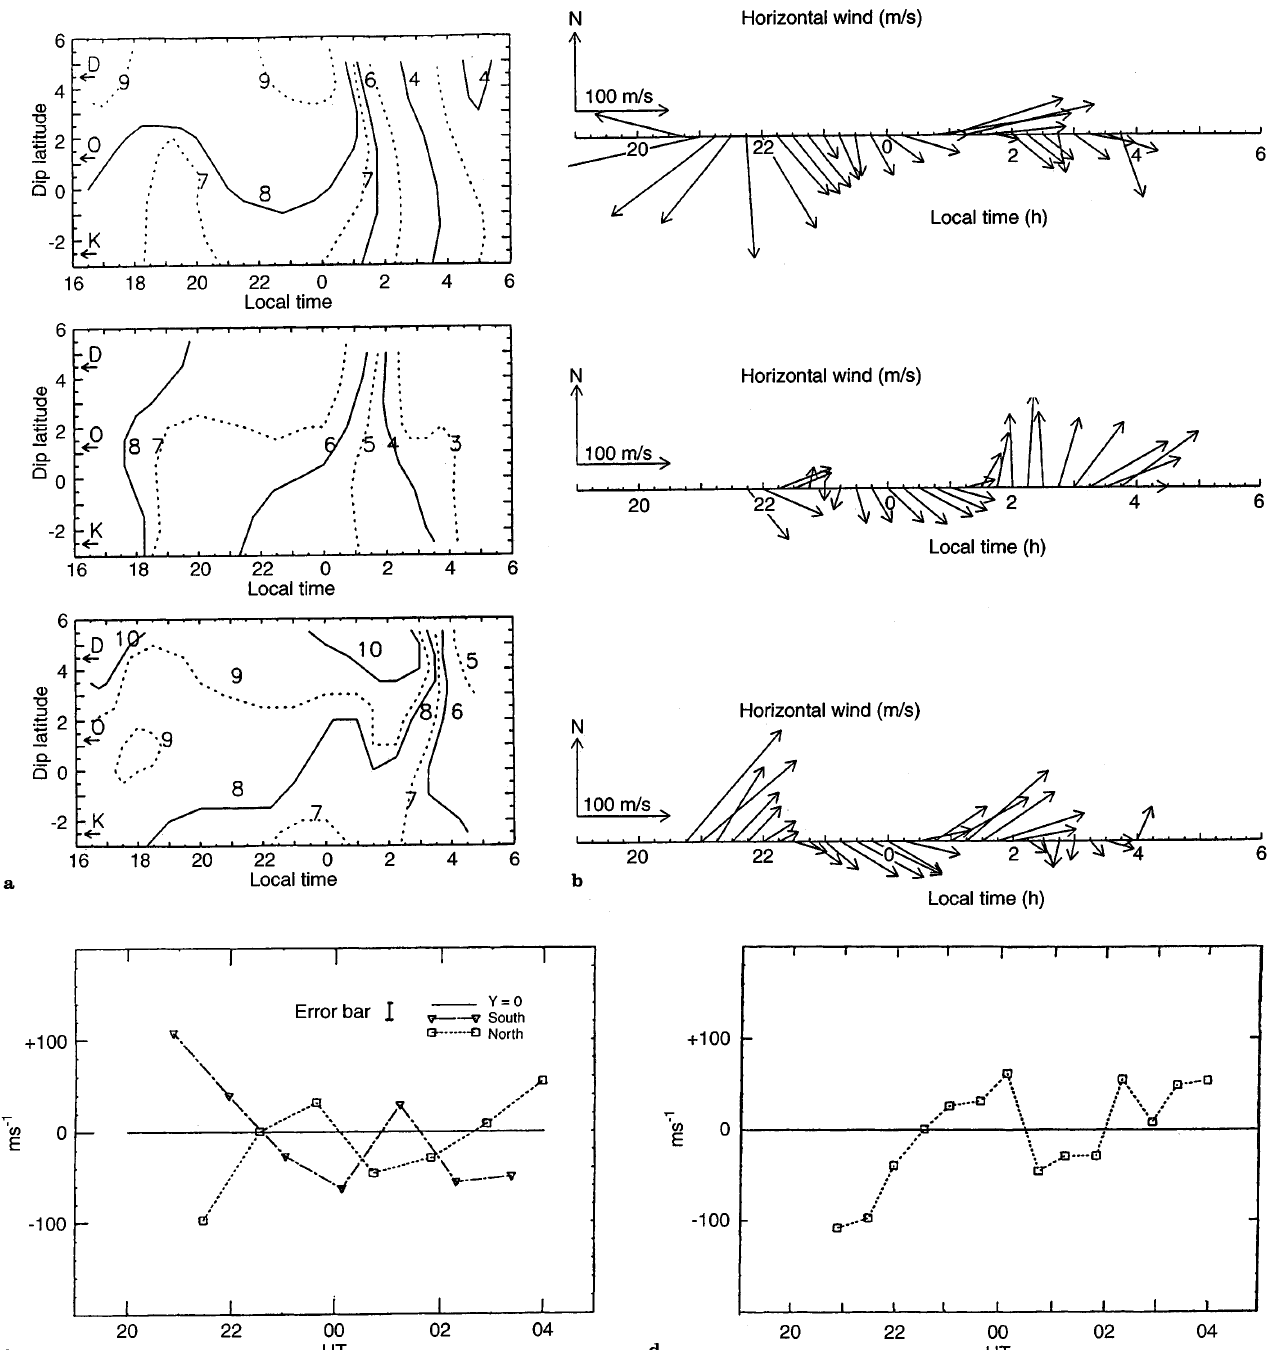
interferometer, for the same periods as Fig. 3a. c Plot of line-of-sight velocity components and resulting horizontal vector variations at Korhogo, 3–4 March, 1995 corresponding to Fig. 3b bottom panel . d Plot of line-of-sight velocity for the zonal wind component at Korhogo, 3–4 March, 1995 corresponding to Fig. 3b bottom panel